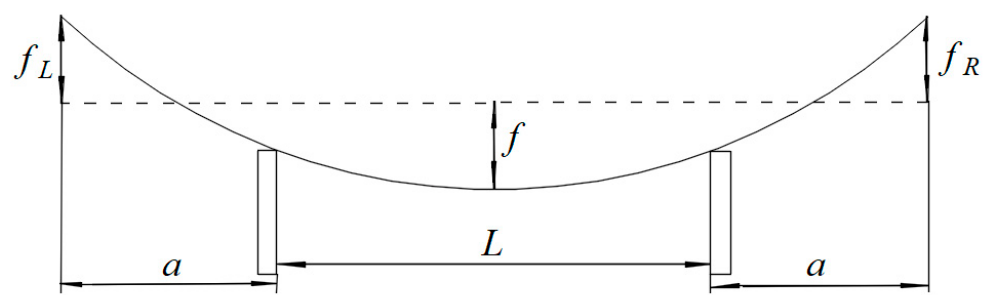
Figure 3. The measuring diagram of the shear tests.